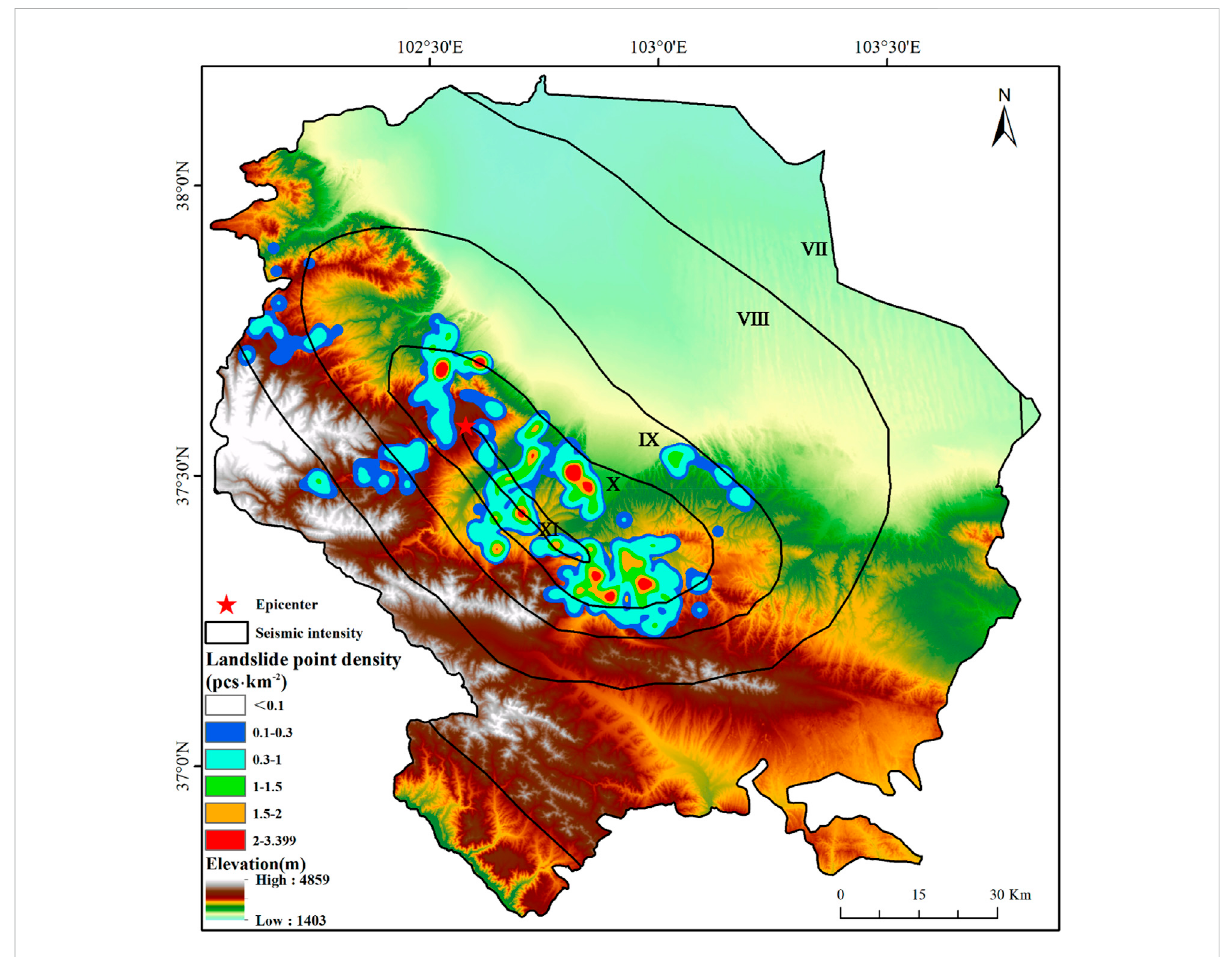
FIGURE 3 Point density map of landslides triggered by the 1927 Gulang